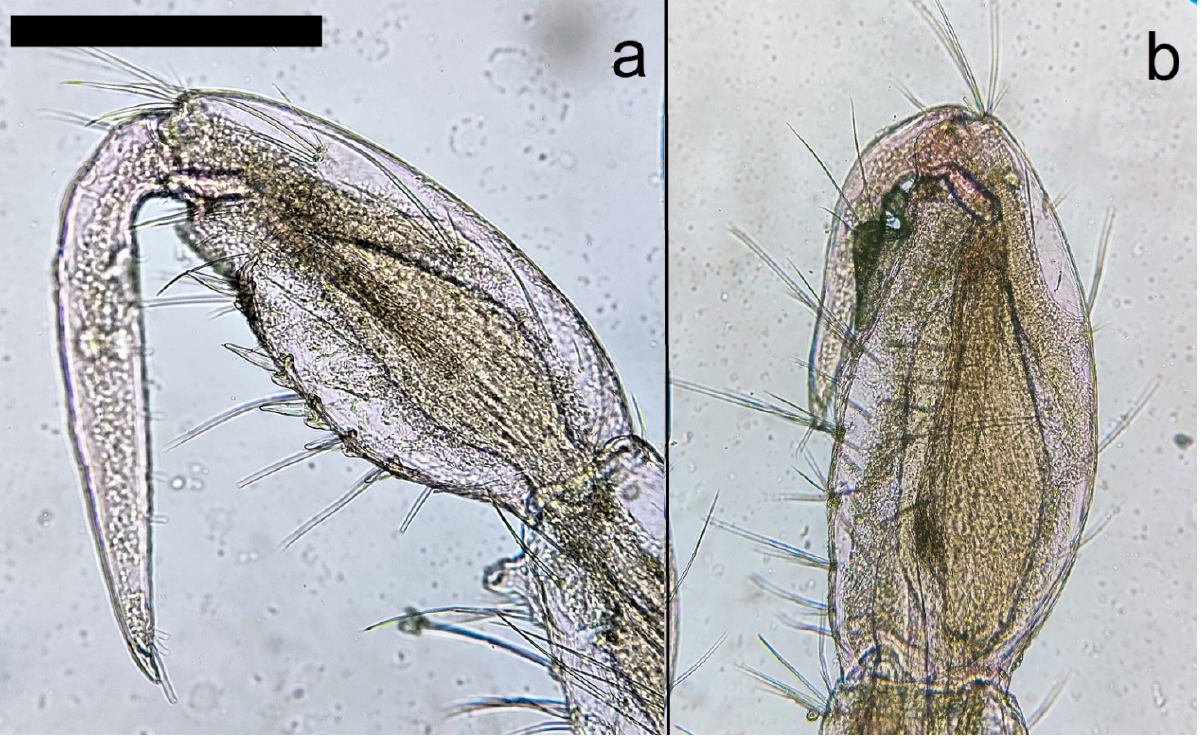
Figure 6. Megamphosus katagani : gnathopod 1 ( a ) and gnathopod 2 ( b ). Scale bar for all the pictures: 0.25 mm. Photo credit: Emanuele Mancini.